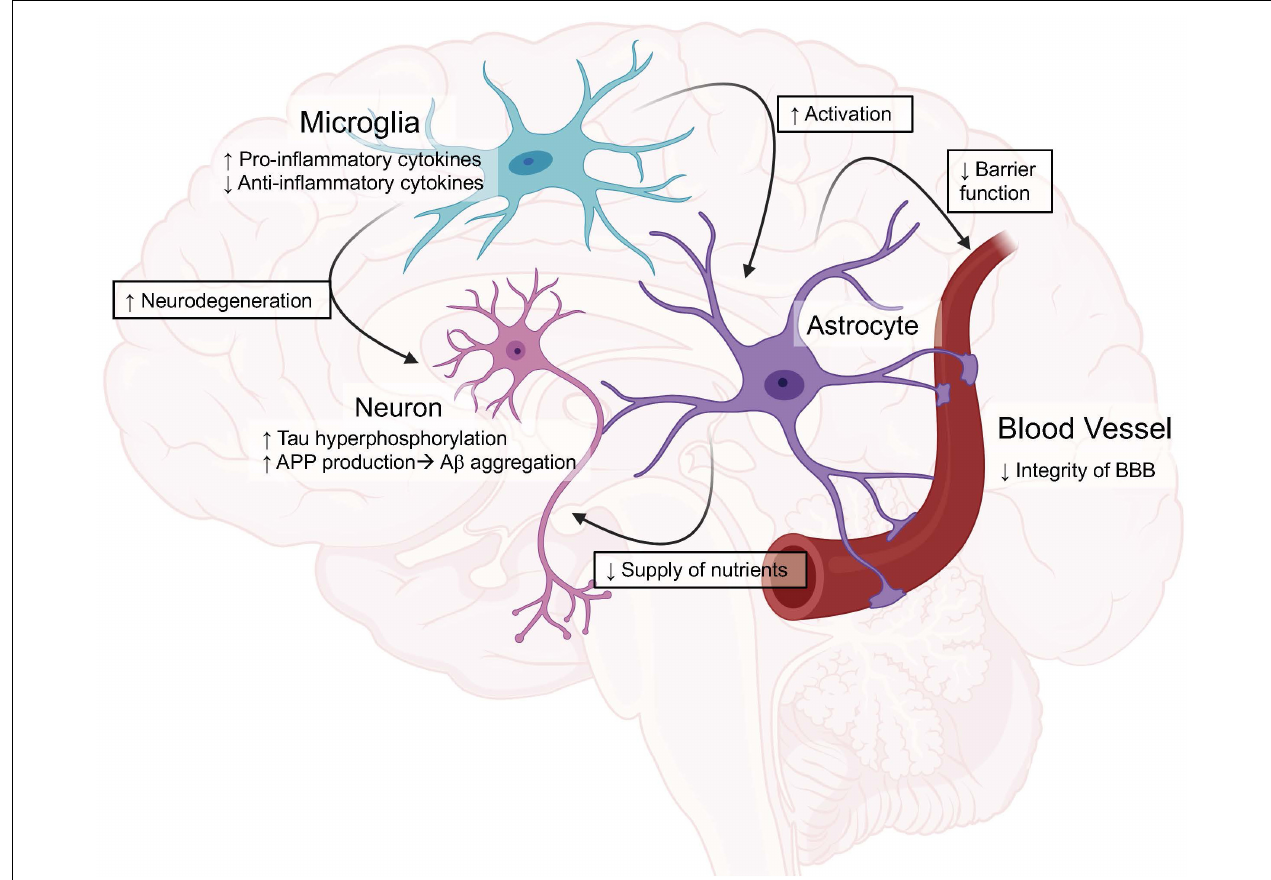
FIGURE 1 | Graphical view of the impact of ApoE4 in the brain compared to ApoE3. These roles will be discussed in depth throughout the review. Created with BioRender.